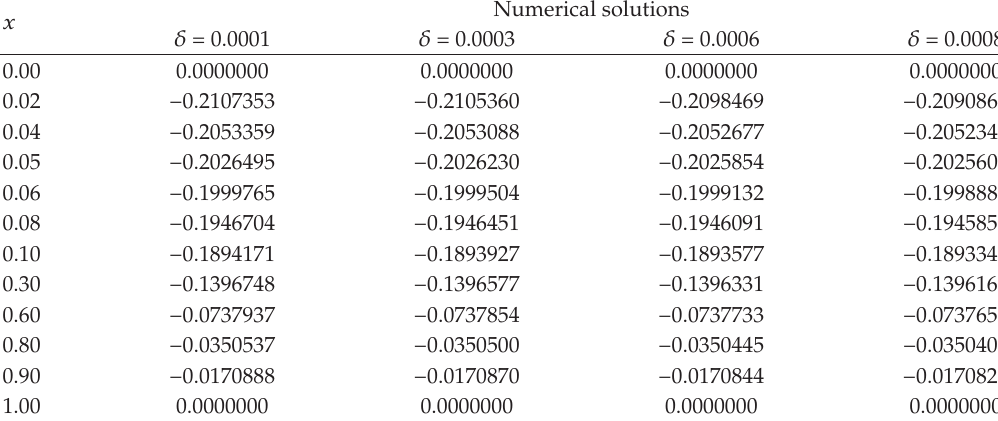
Table 9: Numerical results of Example 4.4 for ε (cid:8) 0 . 001, N (cid:8) 100, and di ff erent values of δ